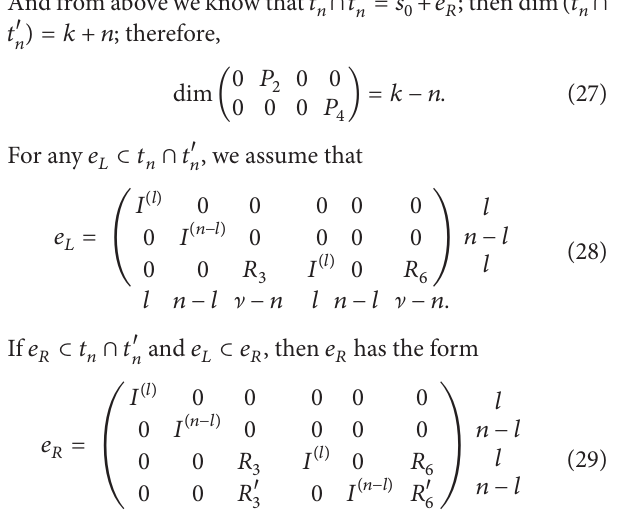
Table 1 we see that the maximum probabilities of